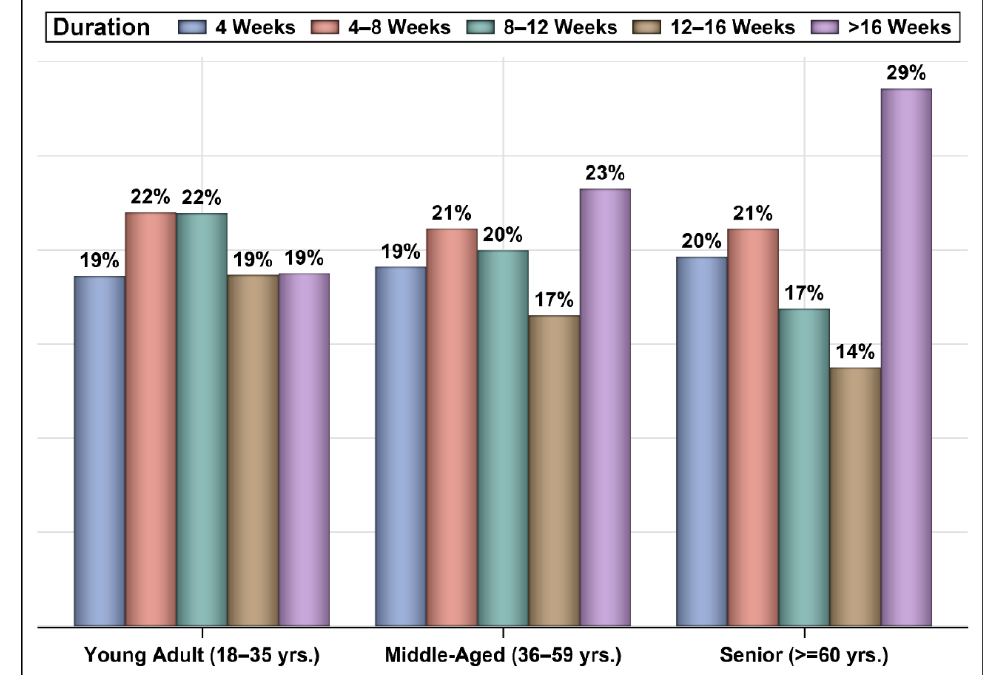
Figure 6. Time from vaccination to infection across age groups (n = 126,169).